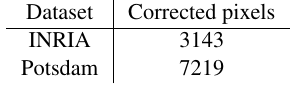
Table 1. Average corrected pixels per click